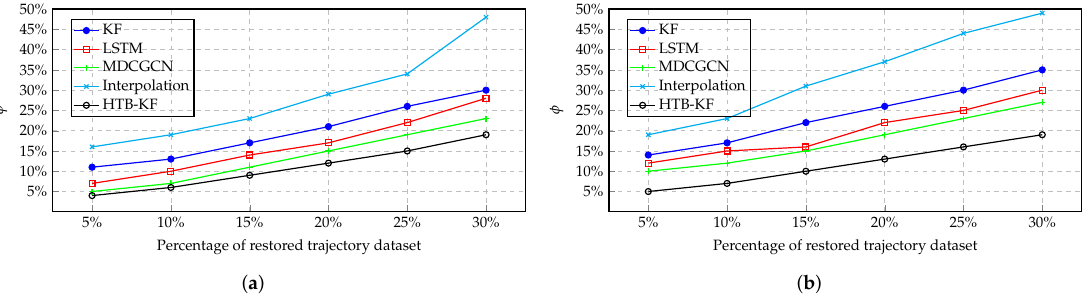
Figure 10. Error rate of velocity information restoration in trajectory segment by different algorithms. ( a ) BJ datasets. ( b ) SH